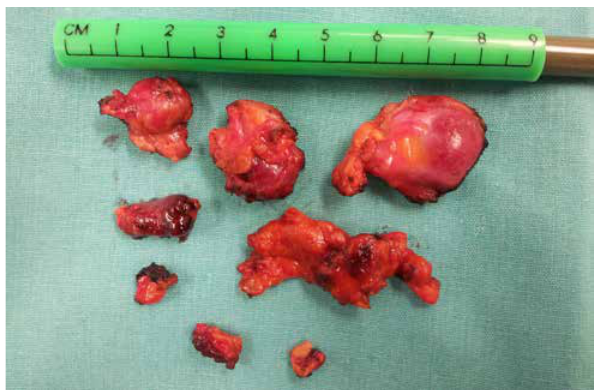
Figure 3: Eight specimens from dissected nodules from